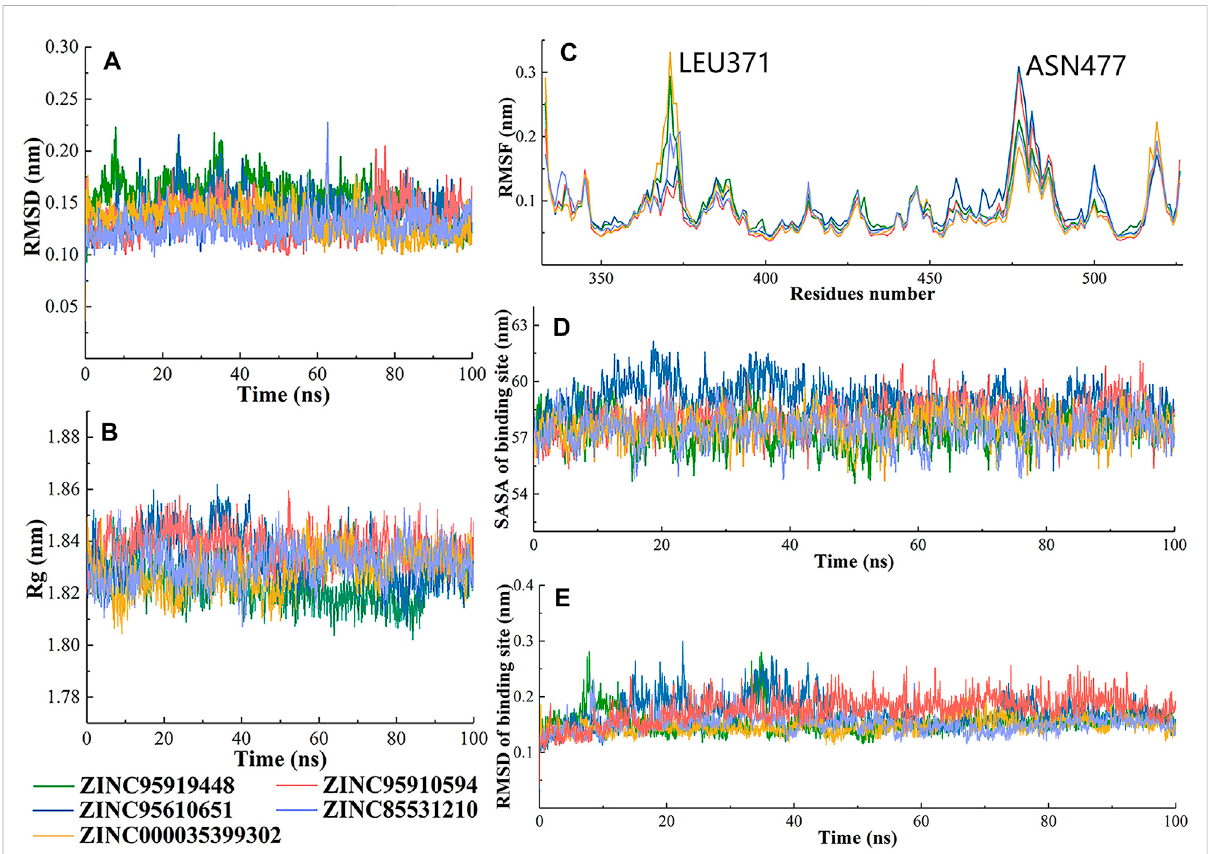
FIGURE 5 Changes in the RBD structures (5 candidate compounds) and its dynamics with respect to time. (A) The RMSD was calculated throughout the MD trajectory simulation time of 100 ns using backbone atoms; (B) Radius of gyration of simulated systems; (C) The RMSF values of simulated systems were plotted using C-alpha atoms; (D) Solvent accessible surface area (SASA) and (E) RMSD of binding sites of RBD